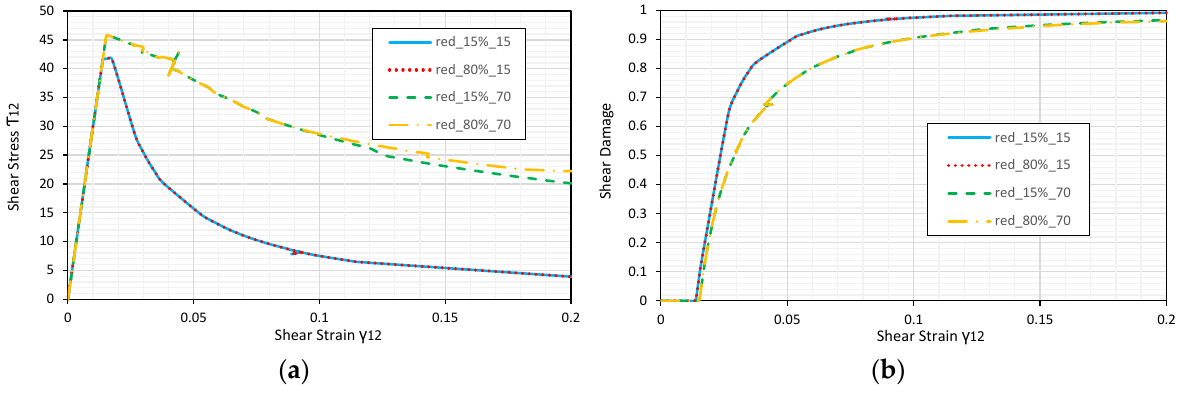
Figure 20. Values in the bolt opening at 30 ᵒ for 15 mm and 70 mm of cover with reduced integration: ( a ) Shear stress vs. shear strain; ( b ) shear damage vs. shear strain cover for the double-lap test.